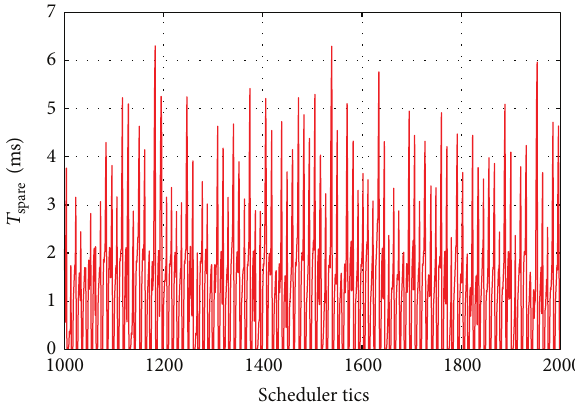
Figure 11: Example of dynamic evolution of 𝑇